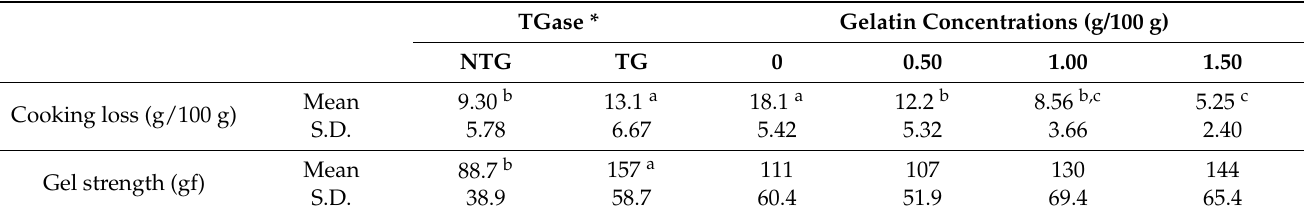
Table 1. Cooking loss and gel strength of myofibrillar protein gels with various gelatin and transglu- taminase